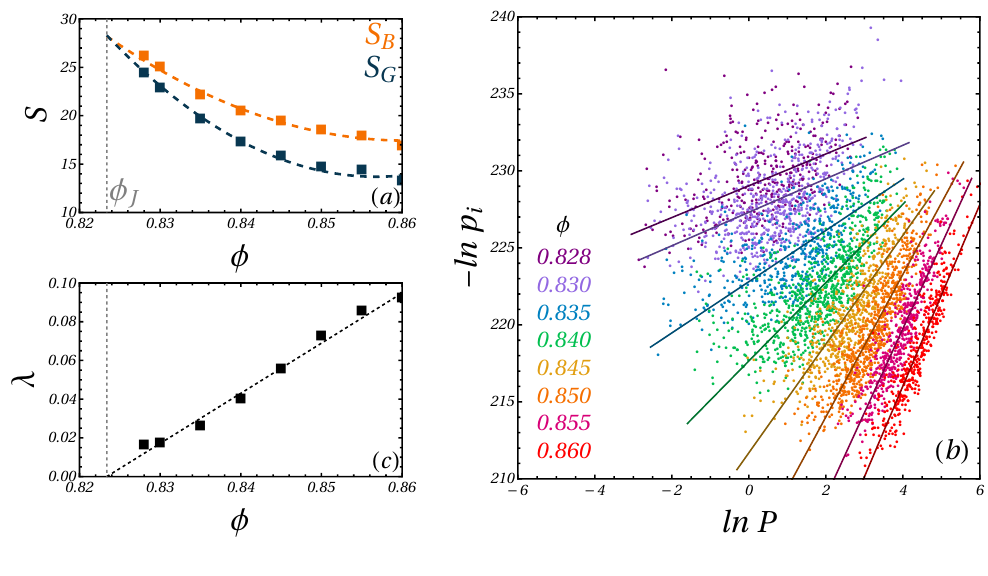
Figure 9: Checking Edwards’ hypothesis. ( a ) Gibbs-Shannon entropy S G (blue) and Boltzmann entropy S B (orange) as a function of ϕ , as obtained from a parameter-free kernel-density estimate (KDE) fit of the distribution of basin volumes. The dashed curves are second-order polynomial fits. As ϕ approaches the unjamming density for N = 64 particles ϕ J = 0 . 82 (dashed gray line), S G tends to S B , implying equiprobability of all states precisely at unjamming. ( b ) Scatter plot of the log of the probability of landing in a given basin, p i (proportional to the volume v i ) against the log of the pressure P measured in that basin. Power-law scaling relations (solid lines) are found for several densities indicated in the inset. ( c ) Exponents found for the power laws of ( b ), plotted against ϕ . The dashed black line is a linear fit, and the dashed gray line indicates ϕ J . The raw data from Ref. [14] was used here and re-analyzed